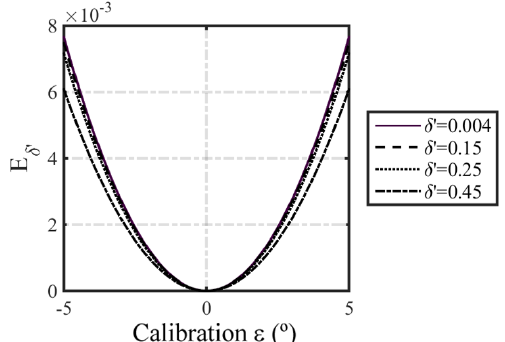
Figure 7. Simulated-to-real δ difference E δ over the misalignment angle ε of the calibrator for different values of δ r according to the label.